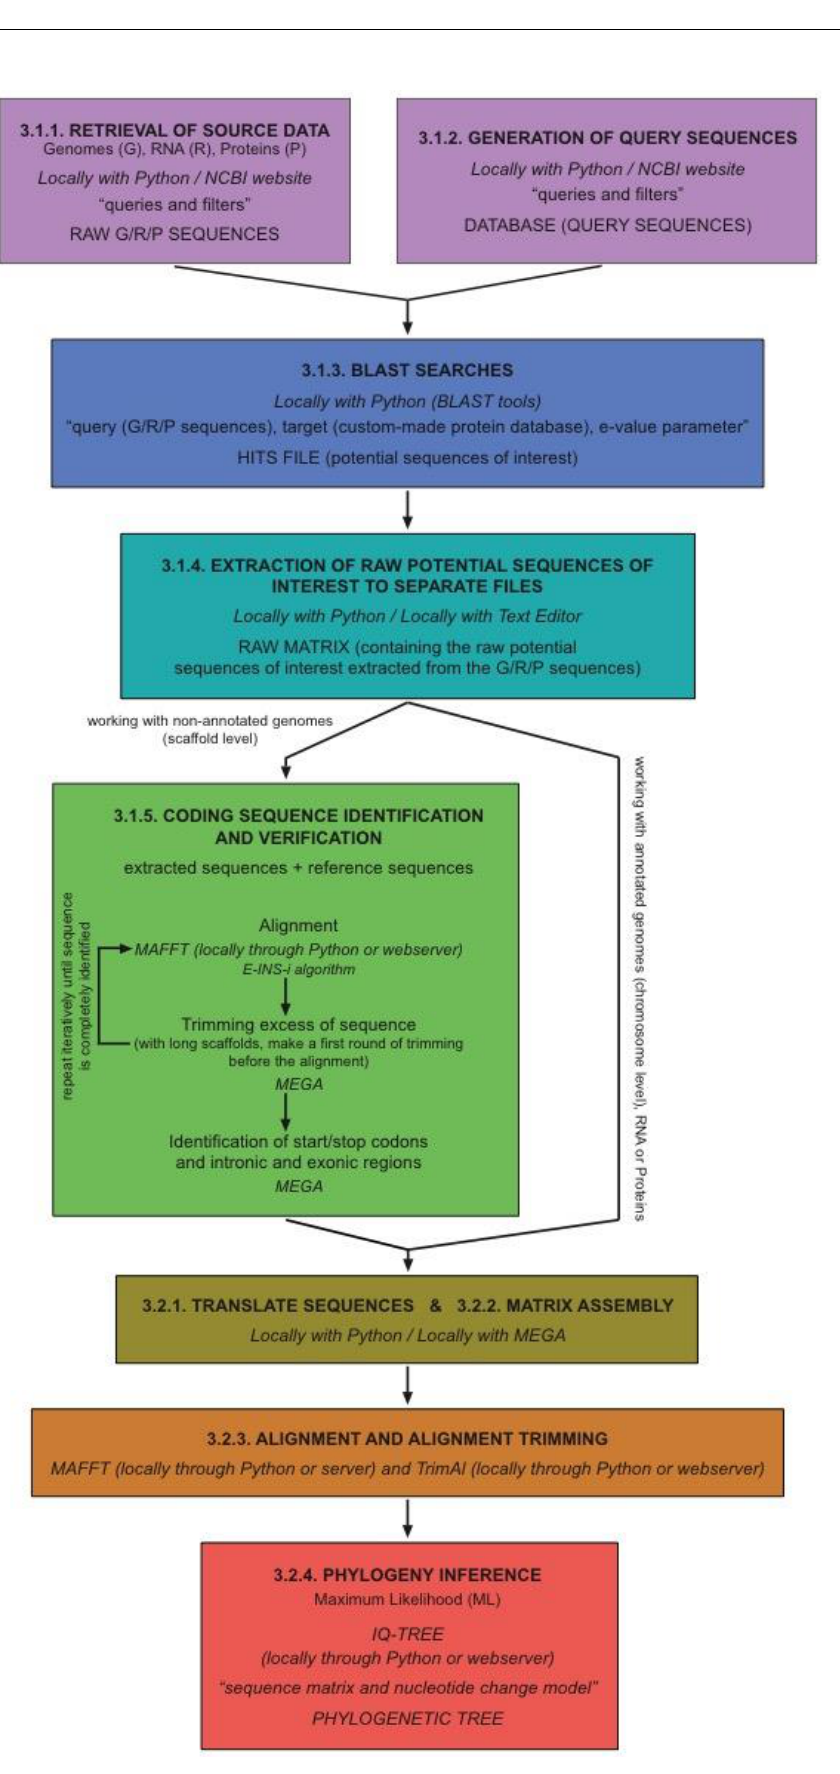
Figure 1. Schematic flowchart of the main steps of the protocol.